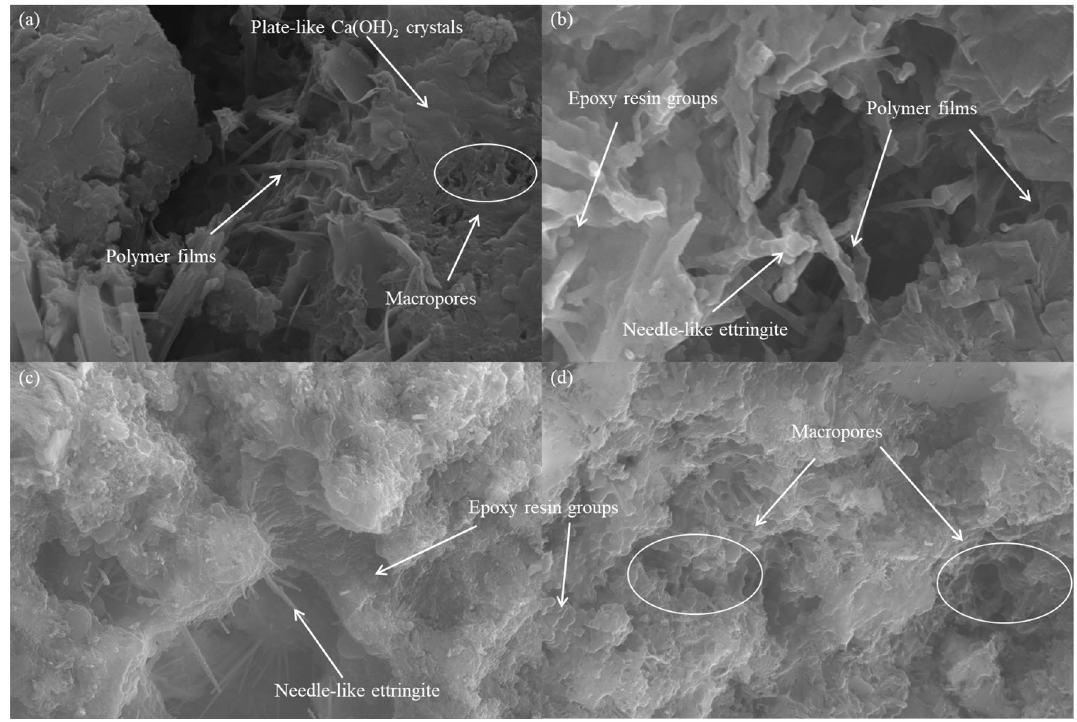
Figure 14. SEM images of modified mortar specimens containing epoxy latex cured for 28 days: ( a ) P/C = 5%, ( b ) P/C = 10%, ( c ) P/C = 15%, and ( d ) P/C =